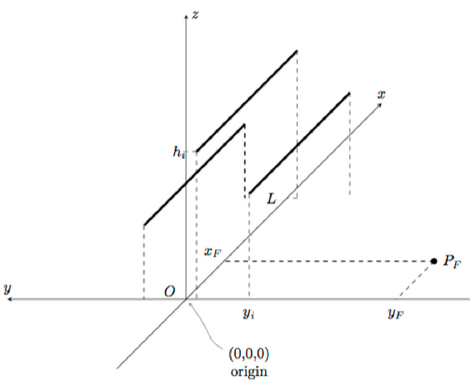
Figure 1. Geometry of the Multiconductor Transmission Line (MTL) system.